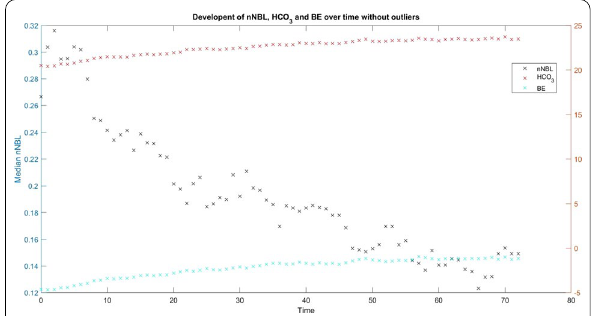
Figure 1. Evolution of nNBL (mmol/h/kg), patient bicarbonate (mmol/l) and base excess (BE, mmol/l) over the course of CRRT. The values are medians of the population at each time interval for all 60 patients with the exclusion of a few statistically identified